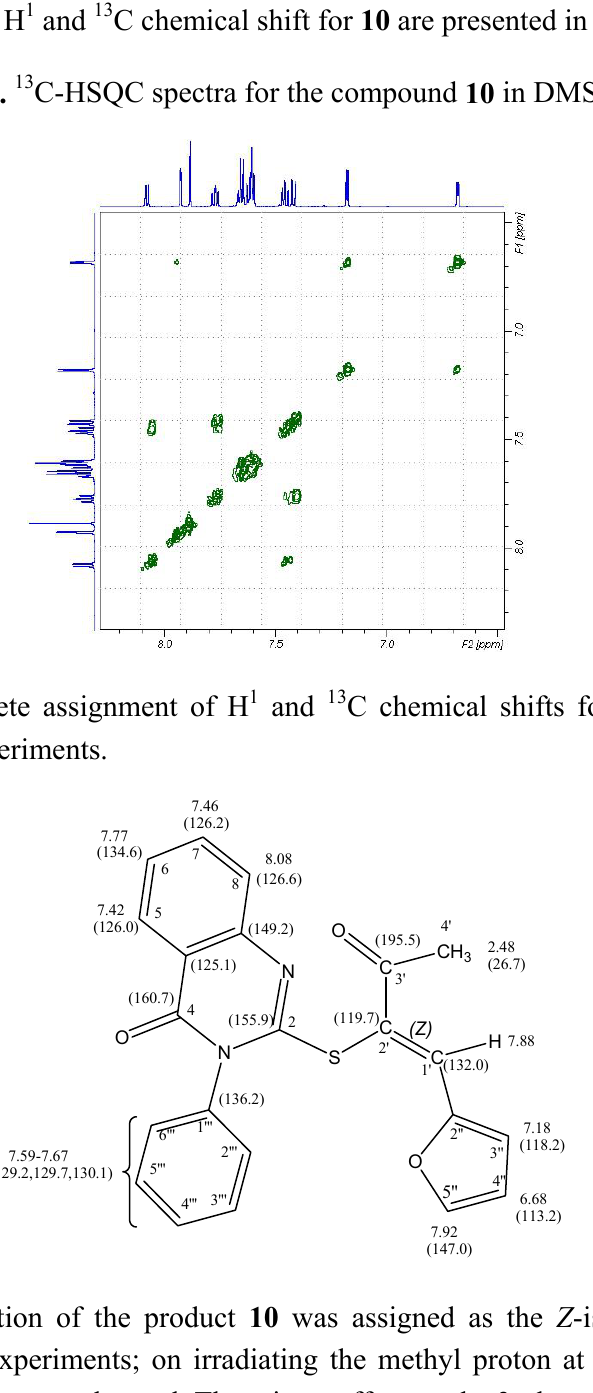
Figure 7. 13 C-HSQC spectra for the compound 10 in DMSO-d